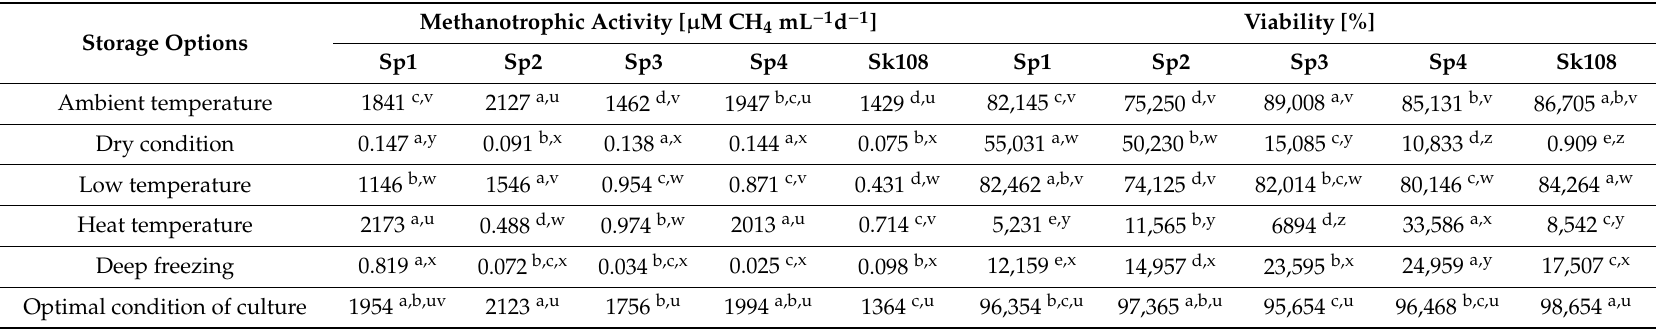
Table 7. Methanotrophic activity and viability of the analyzed biomass in the storage